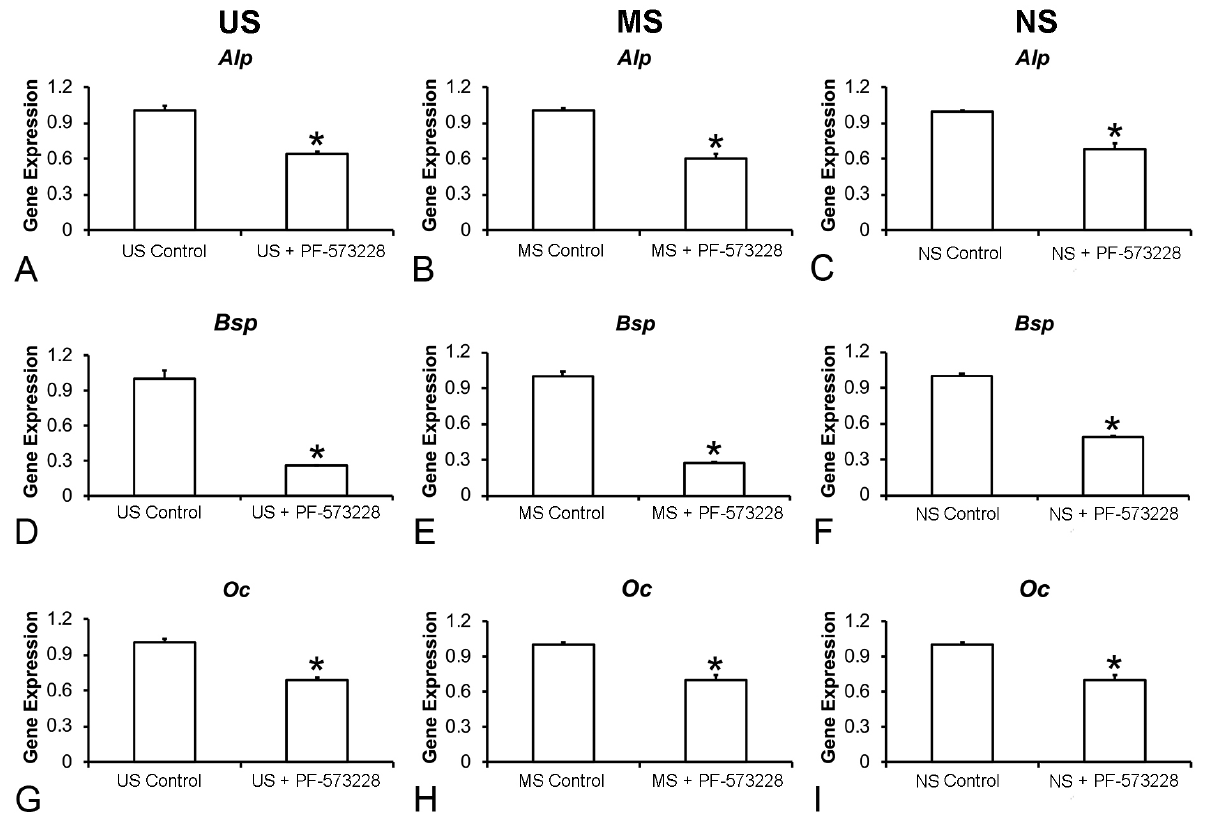
Figure 5- Gene expression of the osteoblastic markers alkaline phosphatase (Alp, A−C), bone sialoprotein (Bsp, D−F), and osteocalcin (Oc, G−I) in cells cultured on US, MS, and NS in presence or absence of 0.1 µM PF-573228 on day 10. The data are presented as mean ± standard deviation (n=3), and asterisks (*) indicate statistically significant differences